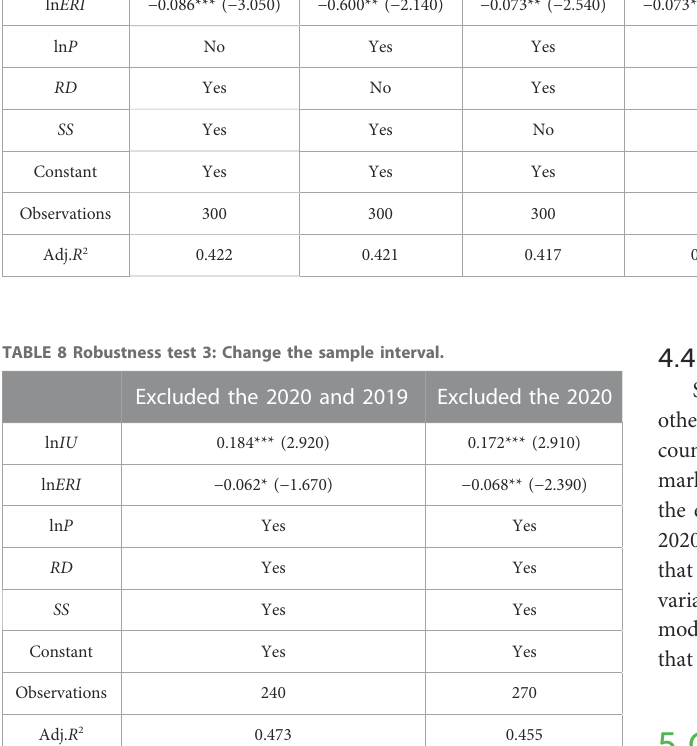
Excluded variables